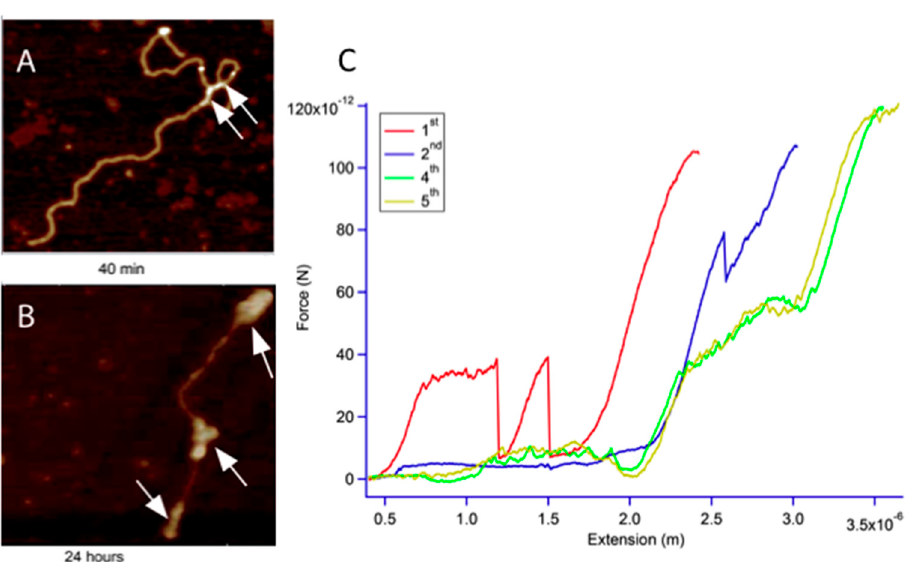
Figure 9. ( A ) DNA molecule incubated 40 min with the platinum compound. Interstrand crosslinks appear after 40 min (arrow). ( B ) DNA molecule incubated 24 h with the platinum compound. Compact structures appear (white arrows). ( C ) Successive force-extension curves on the same DNA molecule after 24 h incubation with the platinum compounds.